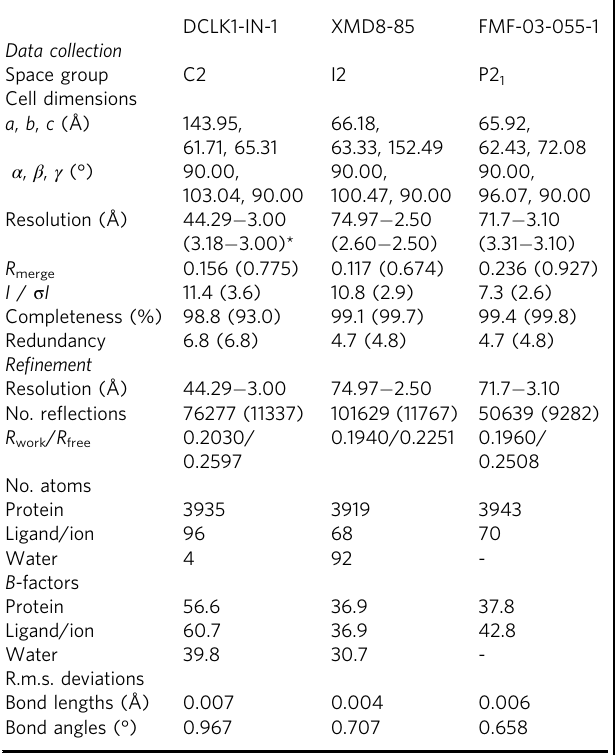
Table 1 Data collection and re fi nement statistics (molecular